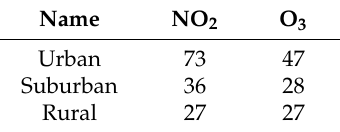
Table 1. Number and type of valid background stations used for the model